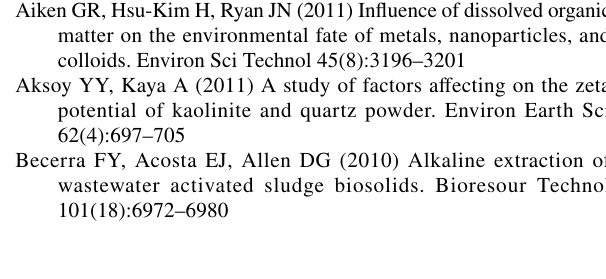
Fig. 10 SS, turbidity, color, and Fe washout removal performances of Runs 1–10 by back-washing at the back-washing hydraulic loading of 1274 L/m 2 /min, where terminal voltage was not applied in Runs 1 and 2 and − 1.0 V terminal voltage was applied in Runs